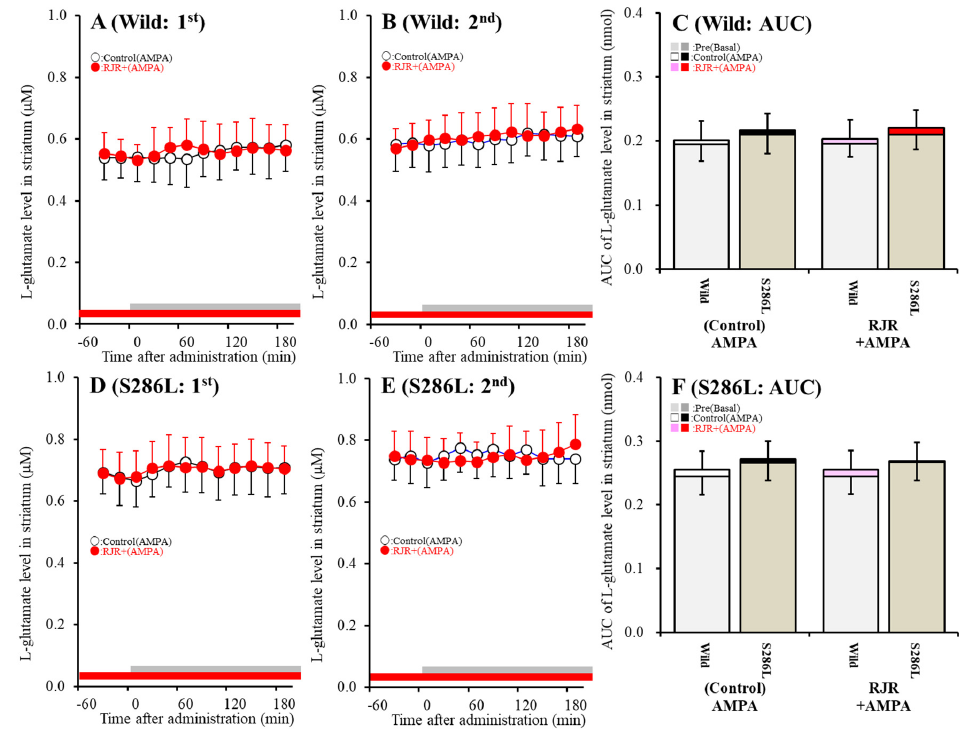
Figure 2. E ff ects of the local administration of 100 µ M RJR2403 into the OFC on 100 µ M AMPA-evoked (perfusion with 100 µ M AMPA into the OFC) L-glutamate release in the striatum, before ( A , D ) and after ( B , E ) hemichannel activation (FCHK-MRS perfusion for 20 min) of the wild-type ( A , B ) and S286L-TG ( D , E ). The perfusion medium in the OFC began with MRS with or without (control) 100 µ M RJR2403 (red bars). After stabilization of the L-glutamate level in the striatum, the perfusion medium was switched to the same MRS containing 100 µ M AMPA for 180 min (first AMPA-evoked stimulation: gray bars). After stabilization of the L-glutamate level in the striatum, the perfusion medium was switched from MRS to FCHK-MRS for 20 min (hemichannel activation). After stabilization of the L-glutamate level in the striatum, the perfusion medium was again switched to the same MRS containing 100 µ M AMPA for 180 min (second AMPA-evoked stimulation: gray bars). Ordinates ( A , B , D , E ) indicate the mean extracellular L-glutamate level ( µ M) ( n = 6), and abscissas indicate the time after AMPA-evoked stimulations (min). ( C , F ) indicate the AUC of the extracellular L-glutamate level (nmol) before (basal extracellular L-glutamate release) and during perfusion with AMPA (from 20 to 180 min) of the wild-type ( A , B ) and S286L-TG ( D , E ), respectively. Notably, the gray columns in ( C , F ) indicate the AUC values of the basal extracellular levels of L-glutamate before AMPA-evoked stimulation (basal L-glutamate release) (over − 60 to 0 min in ( A , B , D , E )). The F-values of the L-glutamate level in the striatum by MANOVA were F event (1,40) = 3.8 ( p > 0.05), F RJR (1,40) = 0.1 ( p > 0.05), F genotype (1,40) = 40.1 ( p < 0.01), F event*RJR (1,40) = 0.1 ( p > 0.05), F event*genotype (1,40) = 0.1 ( p > 0.05), F RJR*genotype (1,40) = 0.1 ( p > 0.05), and F event*RJR*genotype (1,40) = 0.1 ( p >